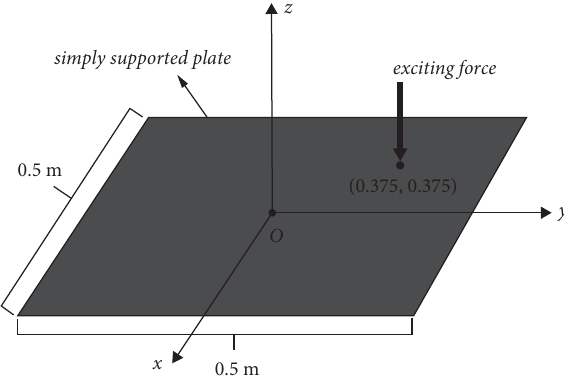
Figure 6: Eccentric excitation